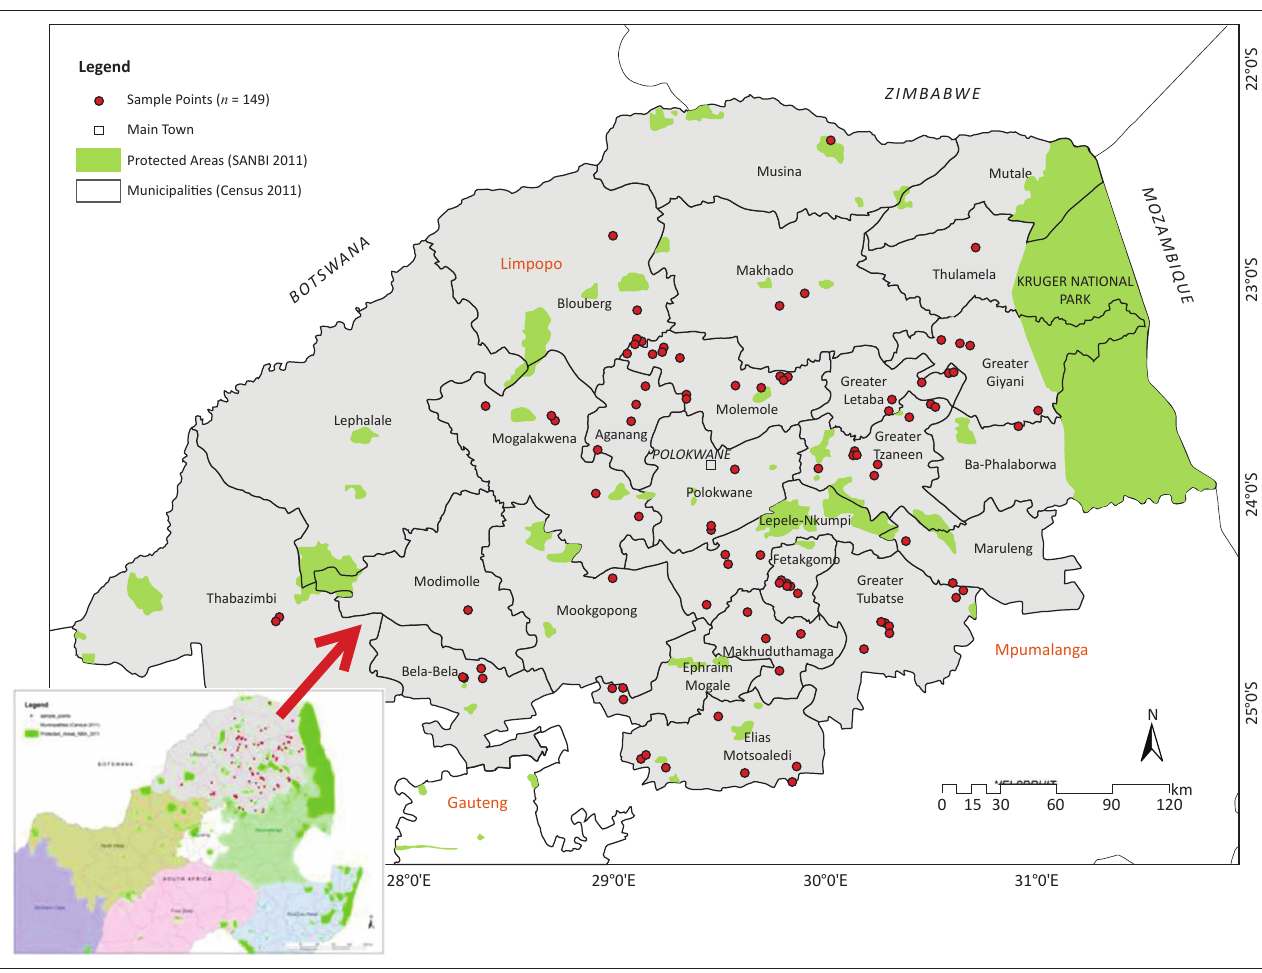
FIGURE 1: Map of surveyed Limpopo province and locations for emerging small-scale pig farmers in Limpopo,